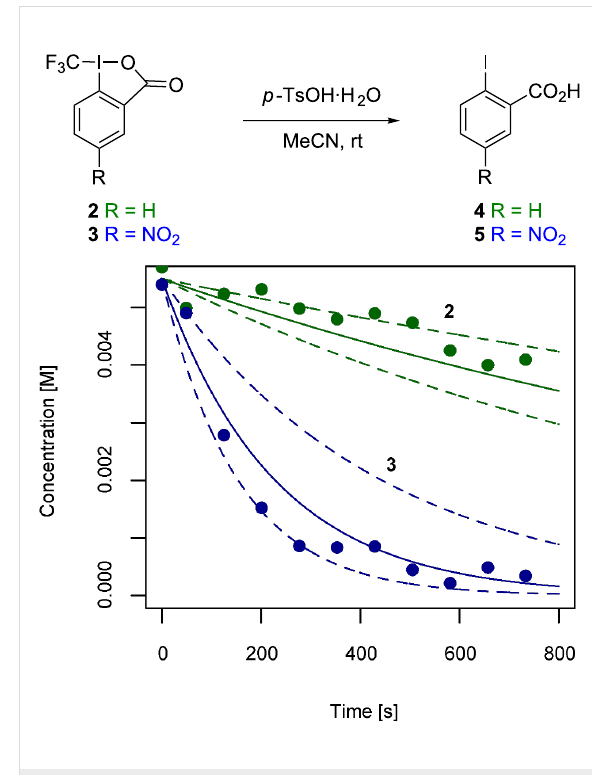
Figure 6: Sample kinetic traces for the decomposition of 2 (green) and 3 (blue) to 4 and 5 , respectively, upon reaction with p -TsOH in MeCN. Solid lines represent the average decay ( k decomp ) based on 6 indi- vidual measurements and dashed lines are decays based on k decomp ± σ